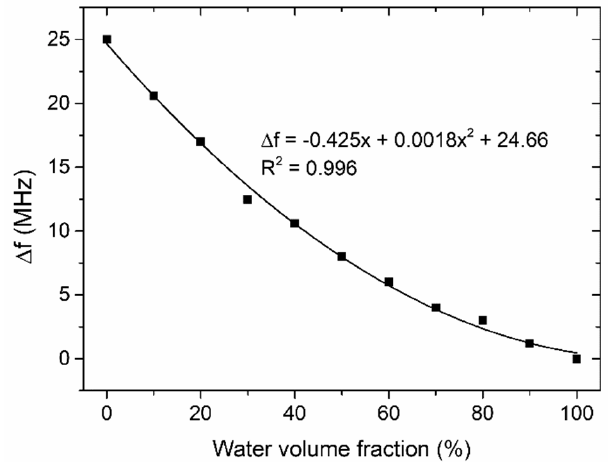
Figure 12. The resonance frequency variation as a function of the water volume fraction in a water/ethanol mixture.